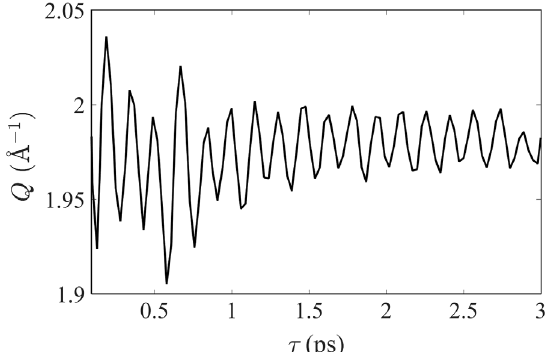
FIG. 9. Oscillation of the node in S ð Q; τ Þ (Fig. 5) in the vicinity of 2 Å − 1